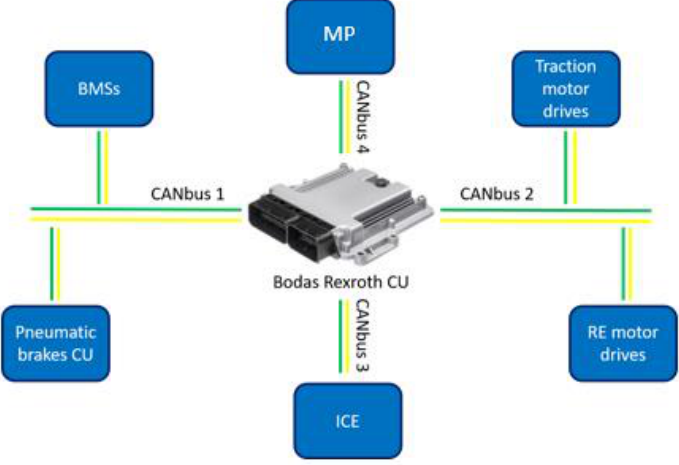
Figure 2. CAN bus scheme of the vehicle.